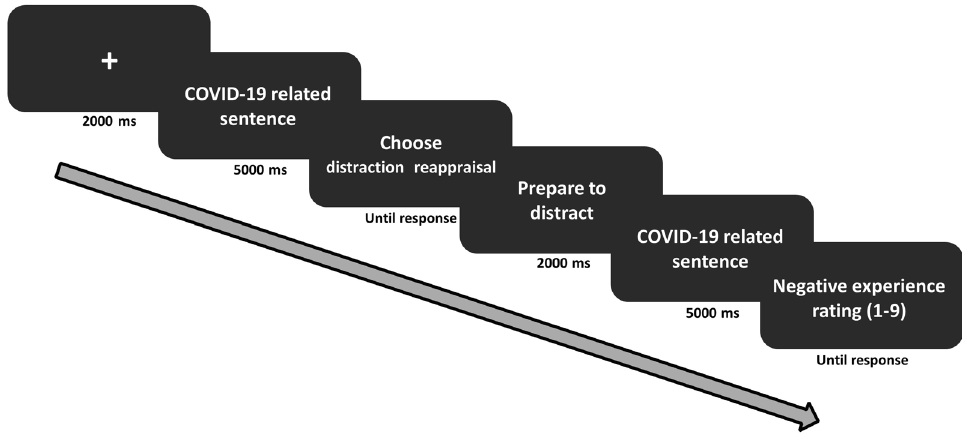
Figure 3. Regulatory selection task. Illustration of a trial structure in Study 2 (an example of a trial where the chosen strategy is